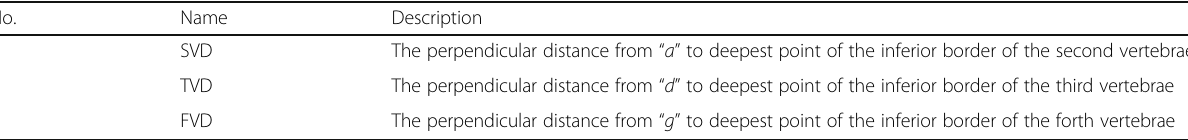
Table 4 The vertebral depth measurements